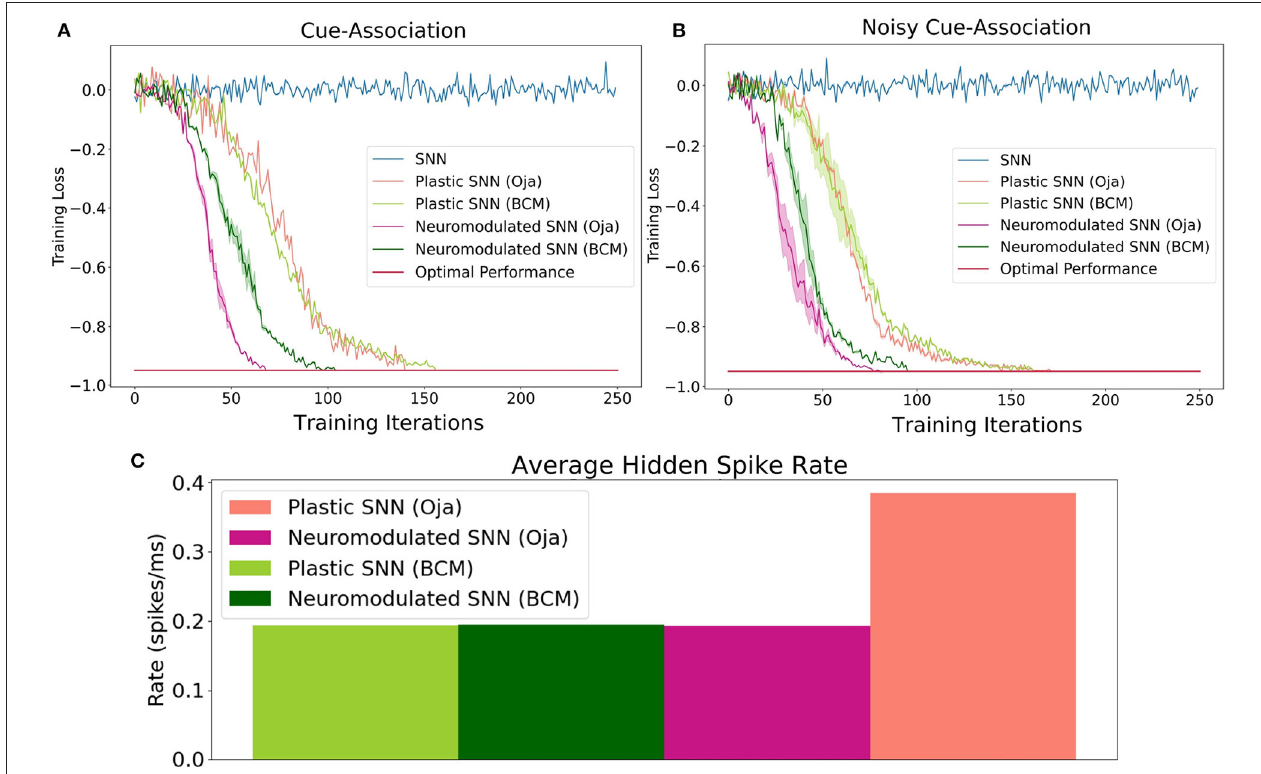
FIGURE 2 | The performance of Oja’s and BCM plastic and neuromodulated learning rules on the low-noise (A) and high-noise (B) environments. (C) The average spike firing rate of hidden layer neurons in the high-noise environments for plastic and neuromodulated Oja’s and BCM. Once the average network training loss is less than − 0.97, which here is consider optimal, the training is halted. Training accuracy is defined as the ratio of correct cues averaged over a series of trials. To perform gradient descent, training loss is this value multiplied by −